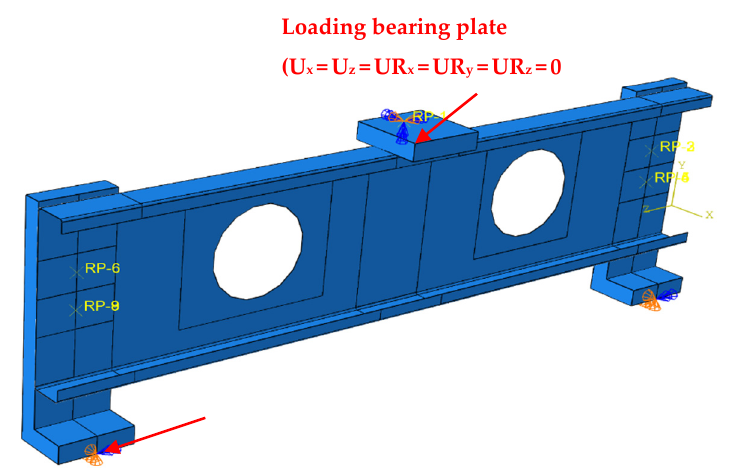
Figure 2. Boundary conditions used in FE models.